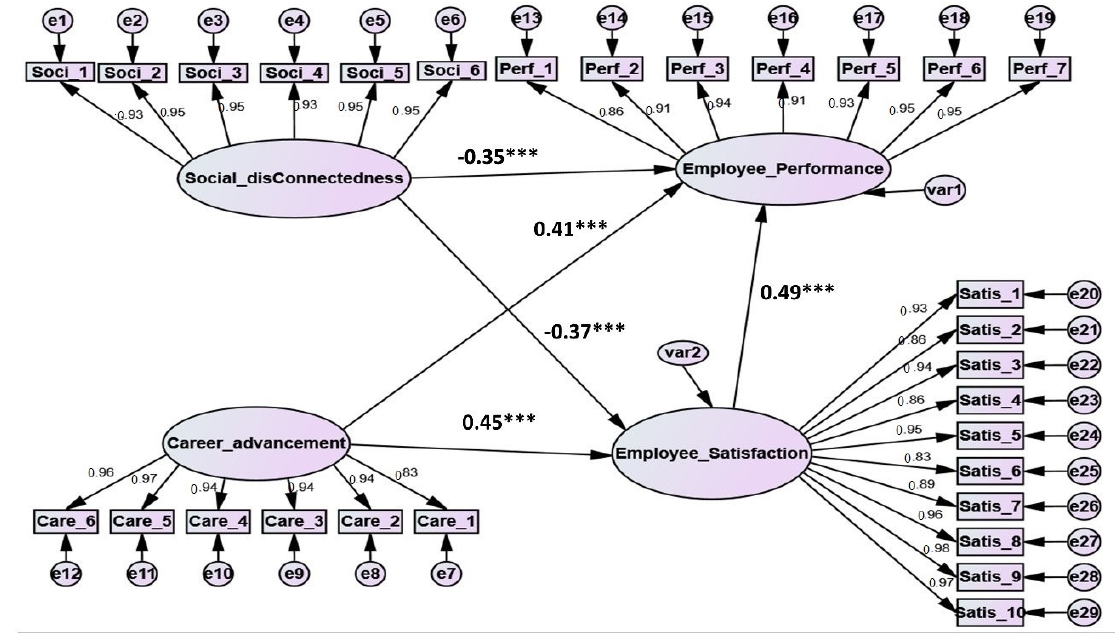
Figure 2. The tested structural and measurement model. ***: Significant level less than